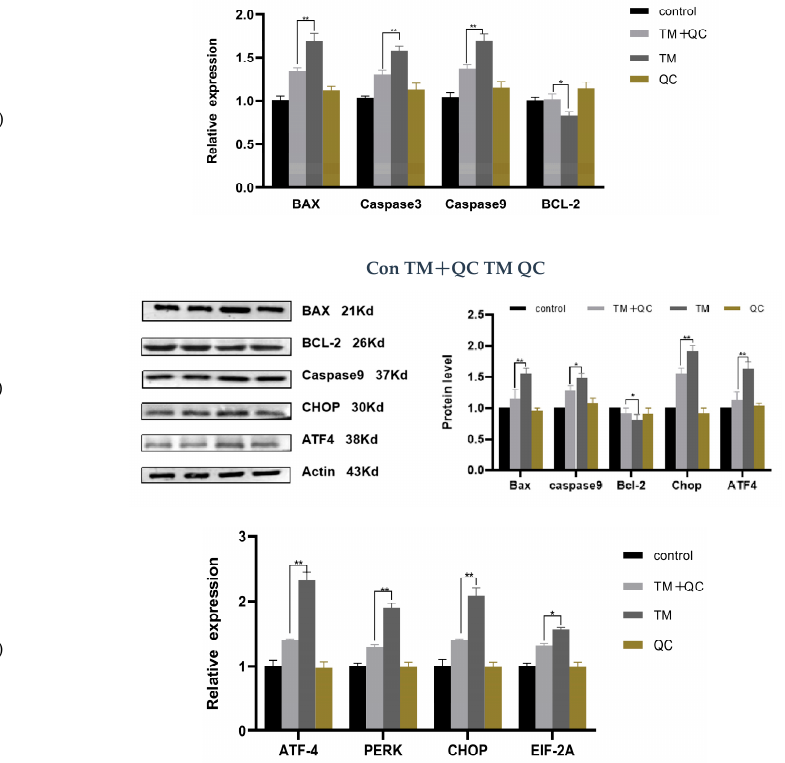
Figure 4. Gene expression changes in GCs after QC treatment: ( A ) The mRNA expression level of Bax , Bcl2 , Caspase3 , and Caspase9 in different treatment groups was examined by q-PCR. ( B ) The expression levels of proteins in different treatment groups were detected by Western blotting. ( C ) The mRNA expression of Atf4 , Chop , Perk , and Eif2a in different treatment groups was examined by q-PCR. The asterisks refer to the level of significance (* p < 0.05, ** p < 0.01). Values are presented as means ± SD for 3 biological replicates.